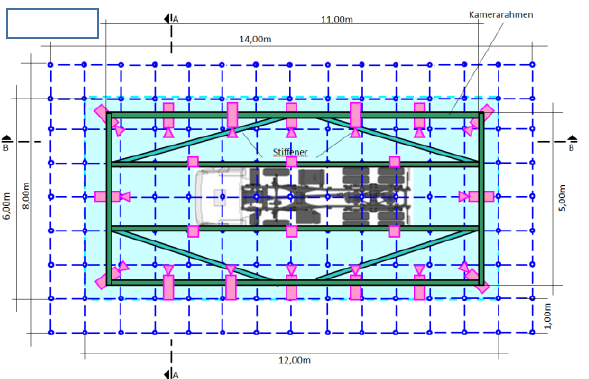
Figure 11: Sketch of a multi camera setup